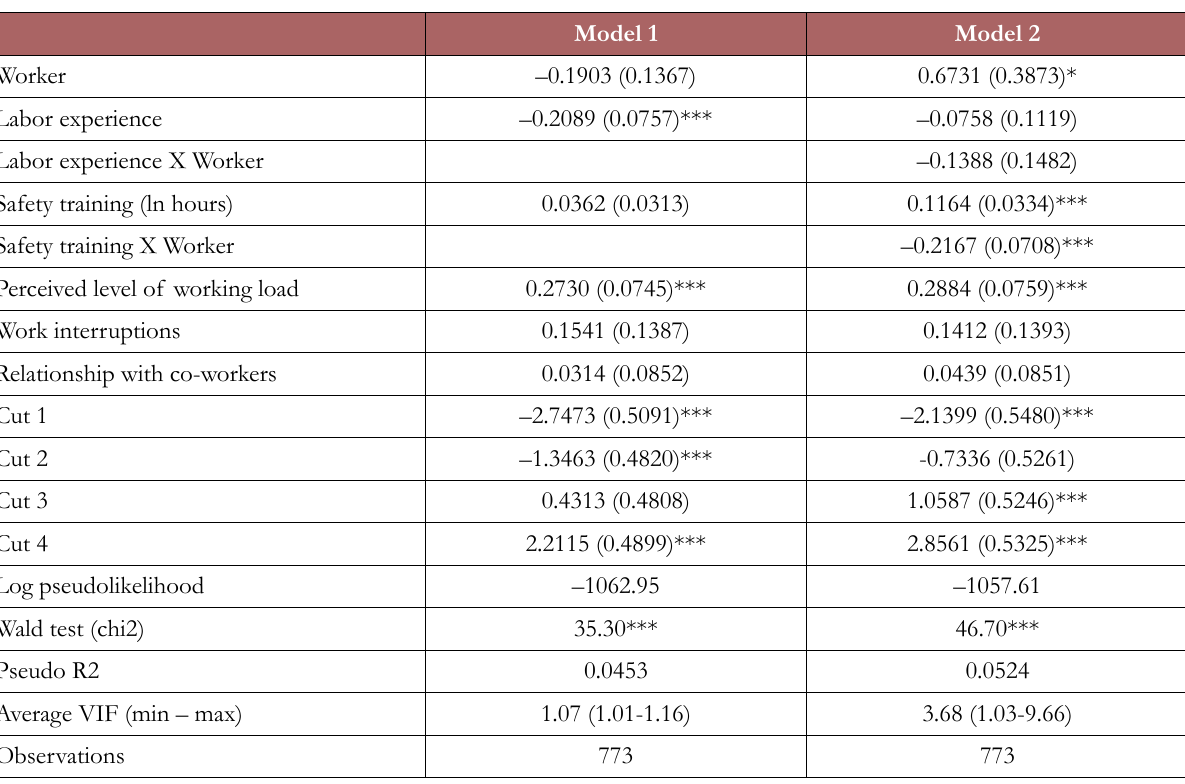
Table 3. Ordered probit model: Perceived safety at